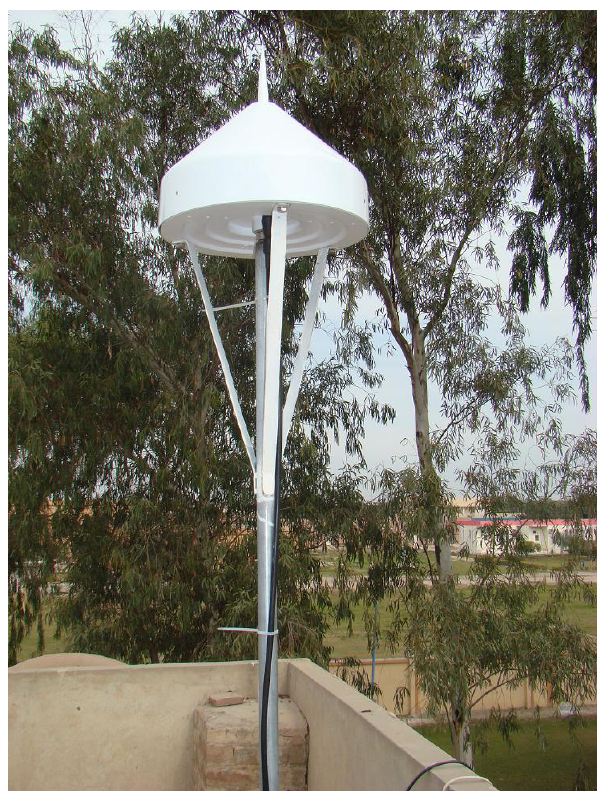
Figure 10. Global Navigation Satellite System (GNSS) signal re- ceiving antenna at